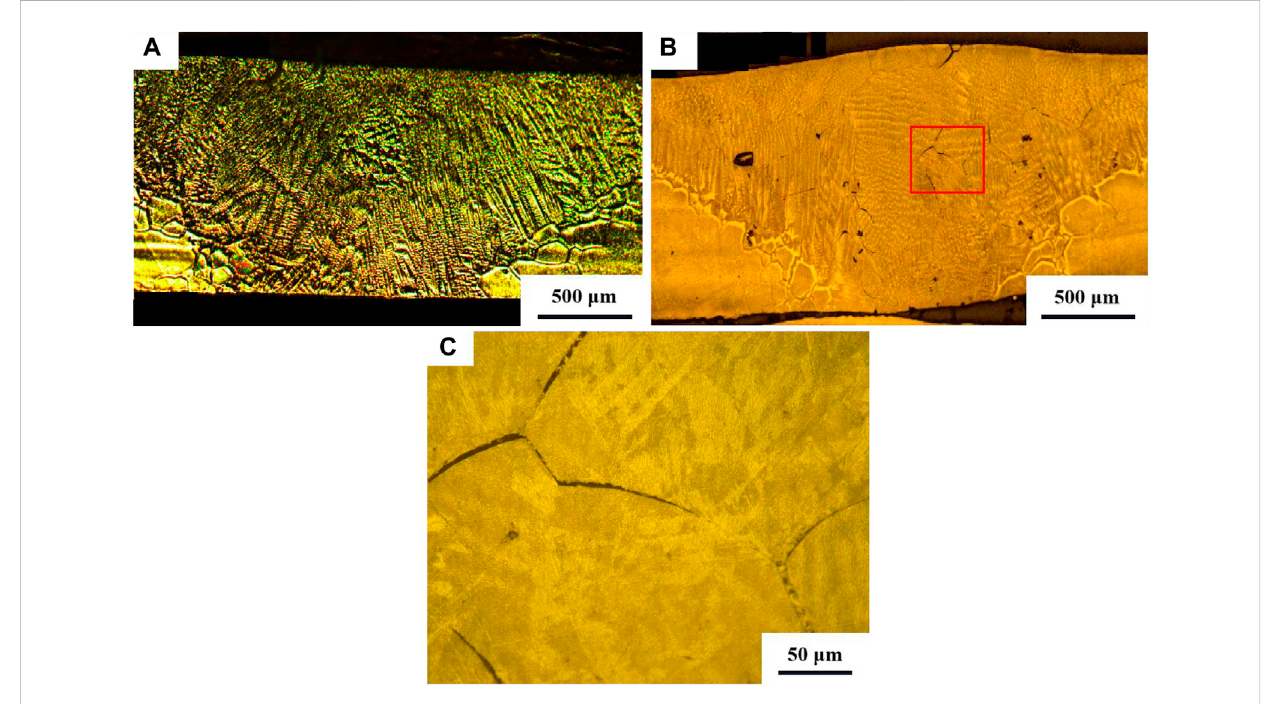
FIGURE 2 Macromorphology of the weld joints of Ti-22Al-25Nb alloy: (A) before post-weld heat treatment and (B) after post-weld heat treatment. (C) Magni fi cation of the area indicated by the rectangular box in (B)